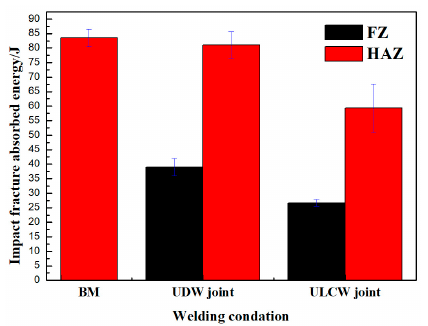
Figure 12. Absorbed energy results for the base material, weld wire, FZ (fusion zone) and HAZ (heat affected zone) impact specimens in UDW joint and ULCW joint at − 40 °C. Table 5. Summary of absorbed energy results for the specimens at − 40 °C. Test Specimens Test